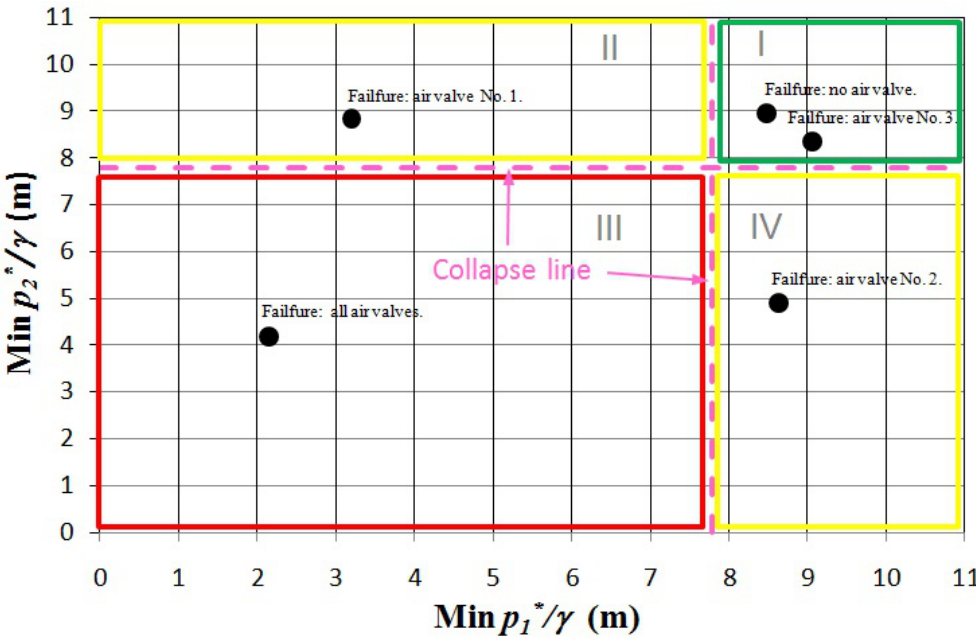
Figure 9. Sensitivity analysis regarding the failure of air